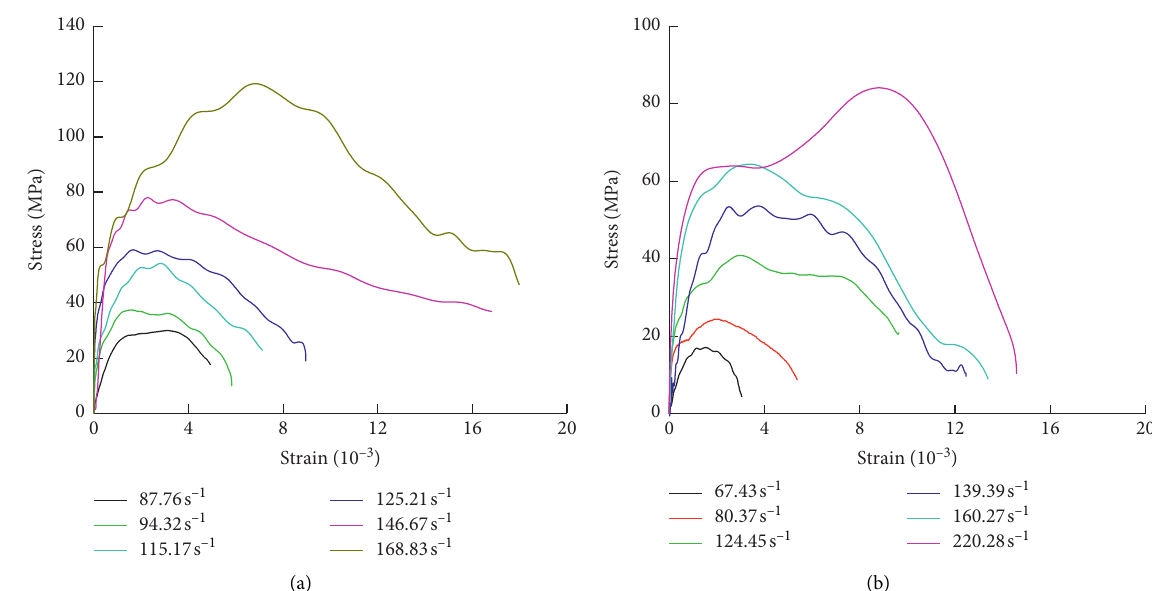
Figure 4: Dynamic stress-strain curve of coal samples under different strain rates. (a) Rockburst-prone coal samples. (b) Nonprone coal samples.